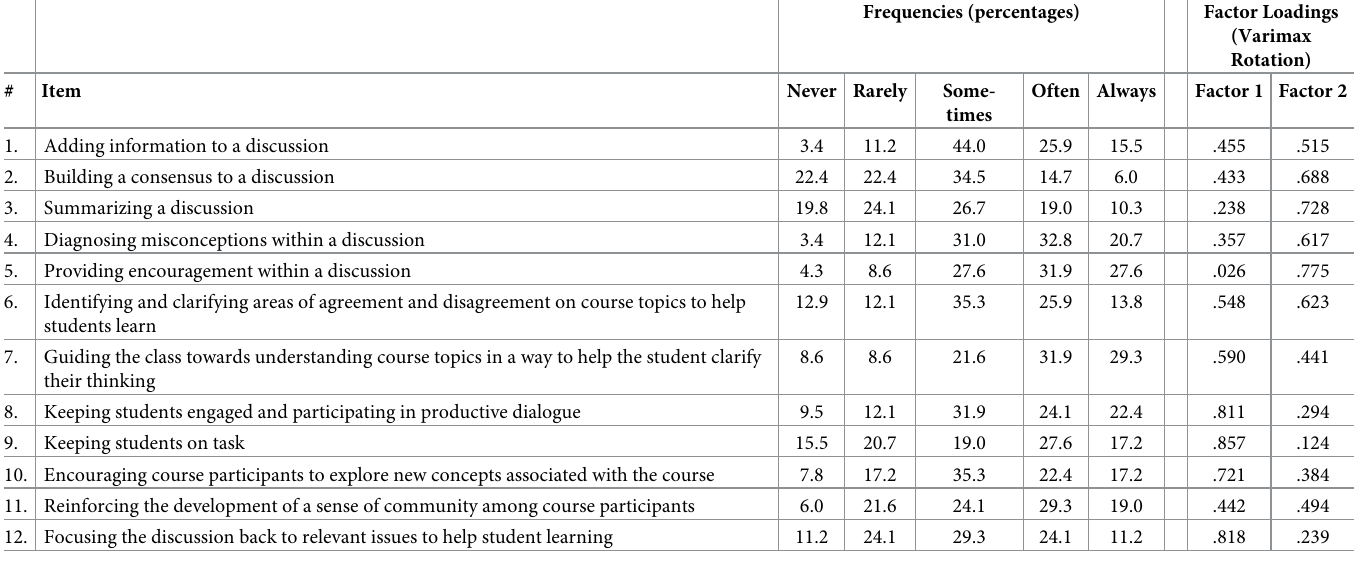
Table 2. Discussion involvement